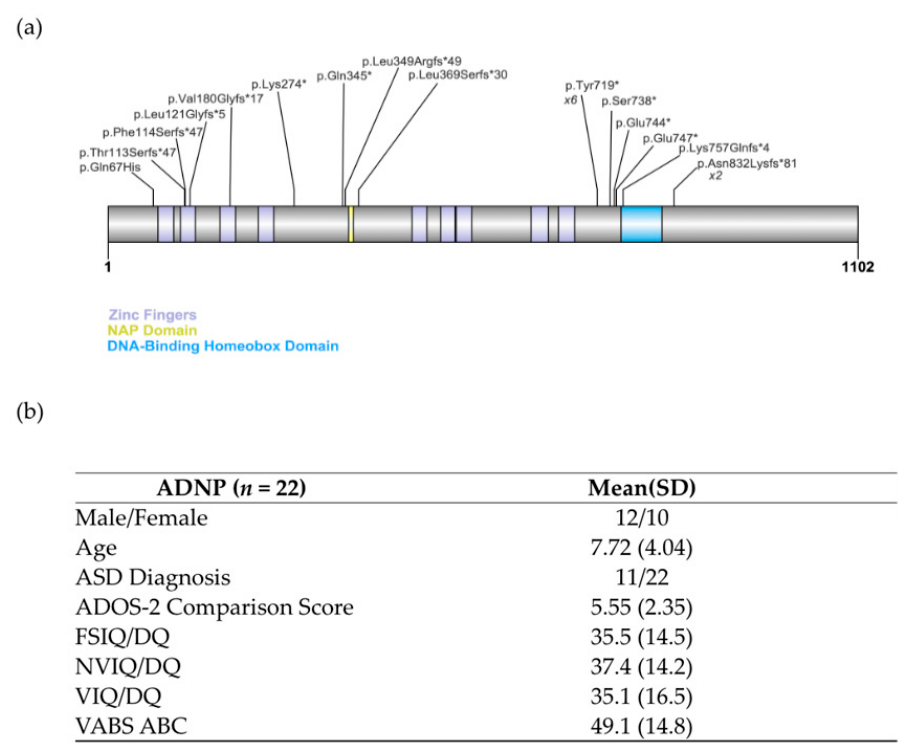
Figure 1. ( a ) ADNP variants in the cohort. The zinc fingers (purple), NAP domain (yellow), and DNA-Binding Homeobox domain (blue) are shown as reported in Uniprot Q9H2P0, (ADNP_Human). Two pathogenic variants are represented by more than one individual in the cohort, p.Tyr19* in six individuals, and p.Asn832Lysfs*81 in two. Not pictured: 5’UTR_EX2del. ( b ) Participant demographics. ADOS-2 comparison scores range from 1–10 with higher numbers reflecting greater symptom severity. IQ and Vineland scores are reflected as standard scores ( M = 100; SD = 15). Developmental Quotients (DQs) were calculated by dividing age equivalents by chronological age for participants above the normed age range on the Mullen and unable to complete the